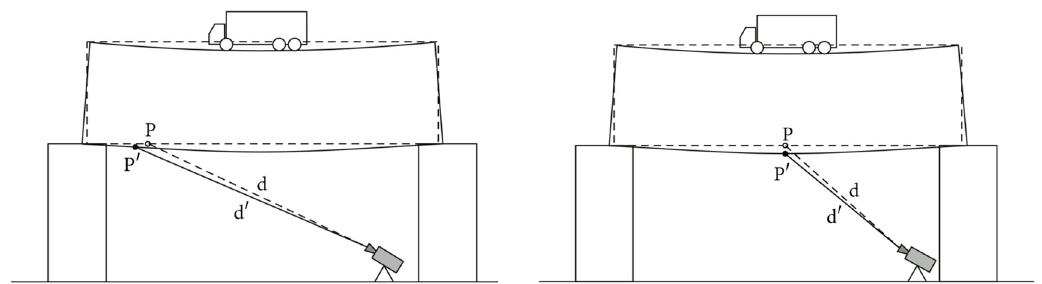
Figure 16. E ff ective displacement of a point P at an edge and close to the central span during the static test of a bridge (after [104]).